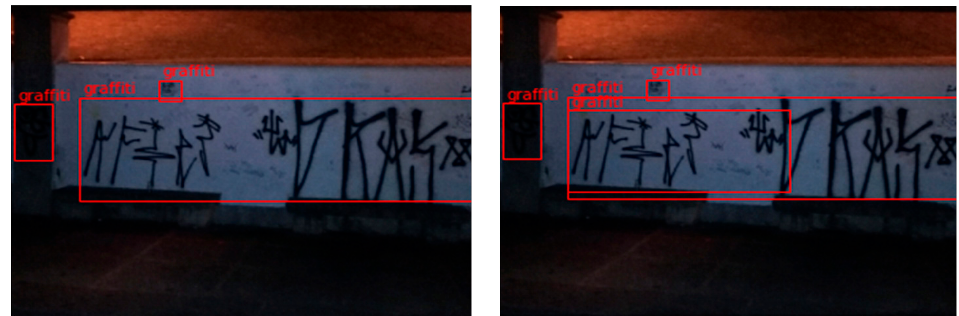
Figure 18. An example of an image where the joining of bounding boxes was necessary.